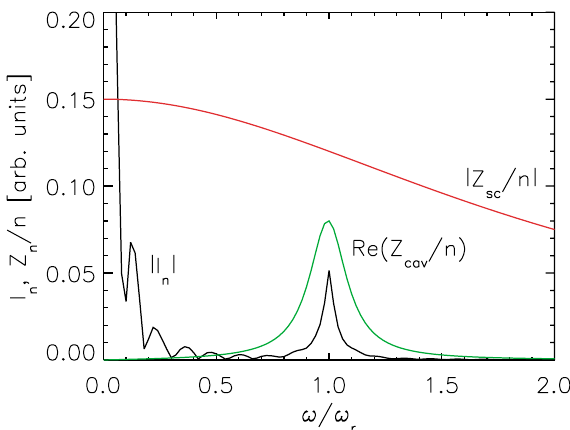
.FIG. 5. (Color) Current amplitude of the modulated bunch (Fig. 4) as a function of the frequency together with the resistive part of the cavity impedance and the space charge impedance (both in a.u.).